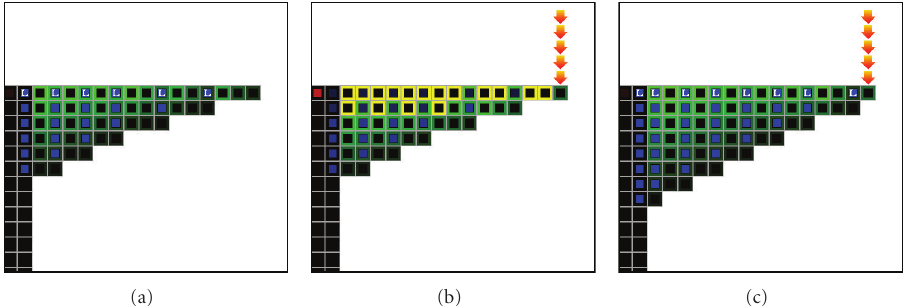
Figure 17: Reaction to additional external force in a process of bridge construction (simulation result of external force acting at the tip of the